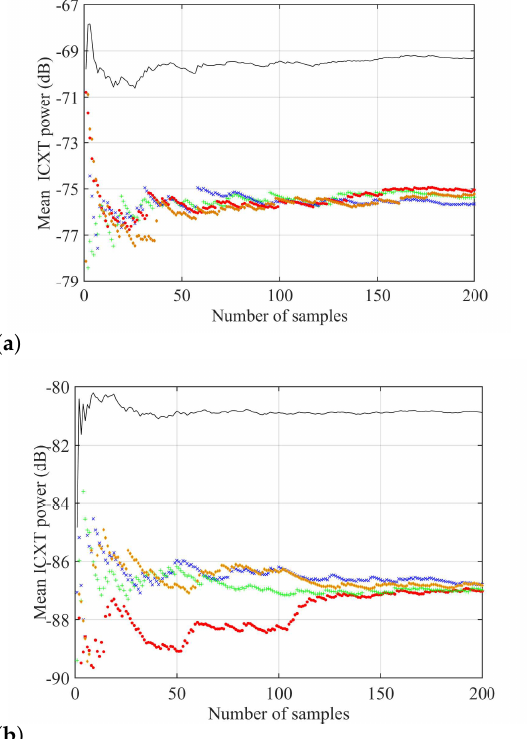
Figure 2. Mean ICXT power in dB at the interfered core output given by (13) and corresponding parcels given by (14) as a function of the number of averaging samples for ( a ) homogeneous single- (cid:0) ∆ (cid:1) β c, mn = 0rad·m − 1 mode WC-MCF with L C = 10m, L B = 1m, ζ x , y = 0.5, and ζ I , Q = 0.5 and (cid:0) ∆ (cid:1) β c, mn = − 701rad·m − 1 ( b ) quasi-homogeneous single-mode WC-MCF with L C = 1m, L B = 1m, (cid:10) (cid:11) (cid:10) (cid:11) (cid:10) (cid:11) XT XT x , I XT x , Q ζ x , y = 0.5, and ζ I , Q = 1. Continuous line: ; mark ( + ): ; mark ( × ): ; mark ( • ): (cid:68) (cid:69) (cid:10) (cid:11) XT y , I XT y , Q ; and mark ( (cid:7) ):